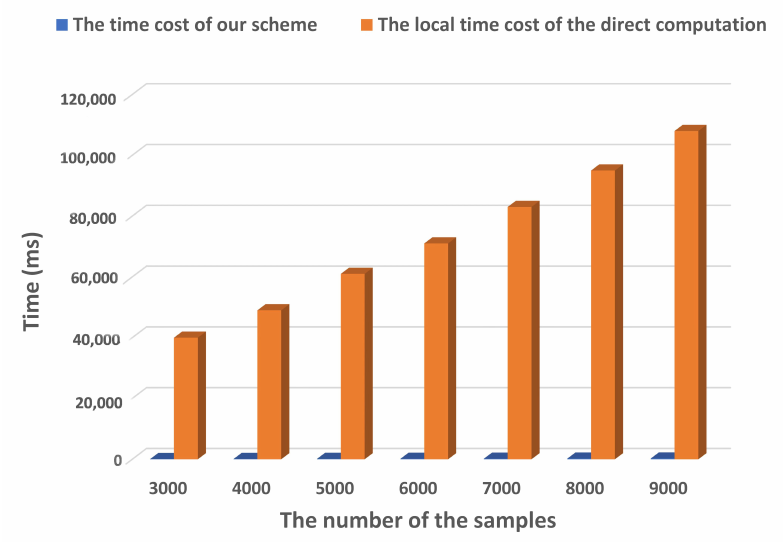
Figure 10. The local time cost of the direct method and our